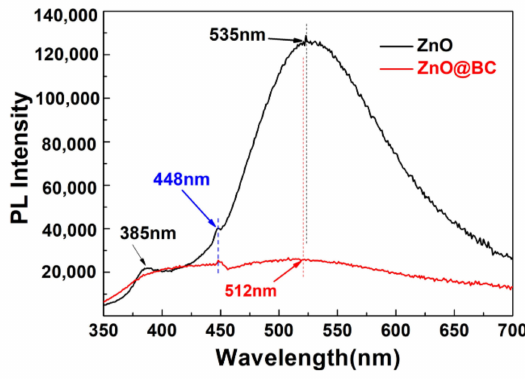
Figure 7. PL spectra of ZnO@BC.